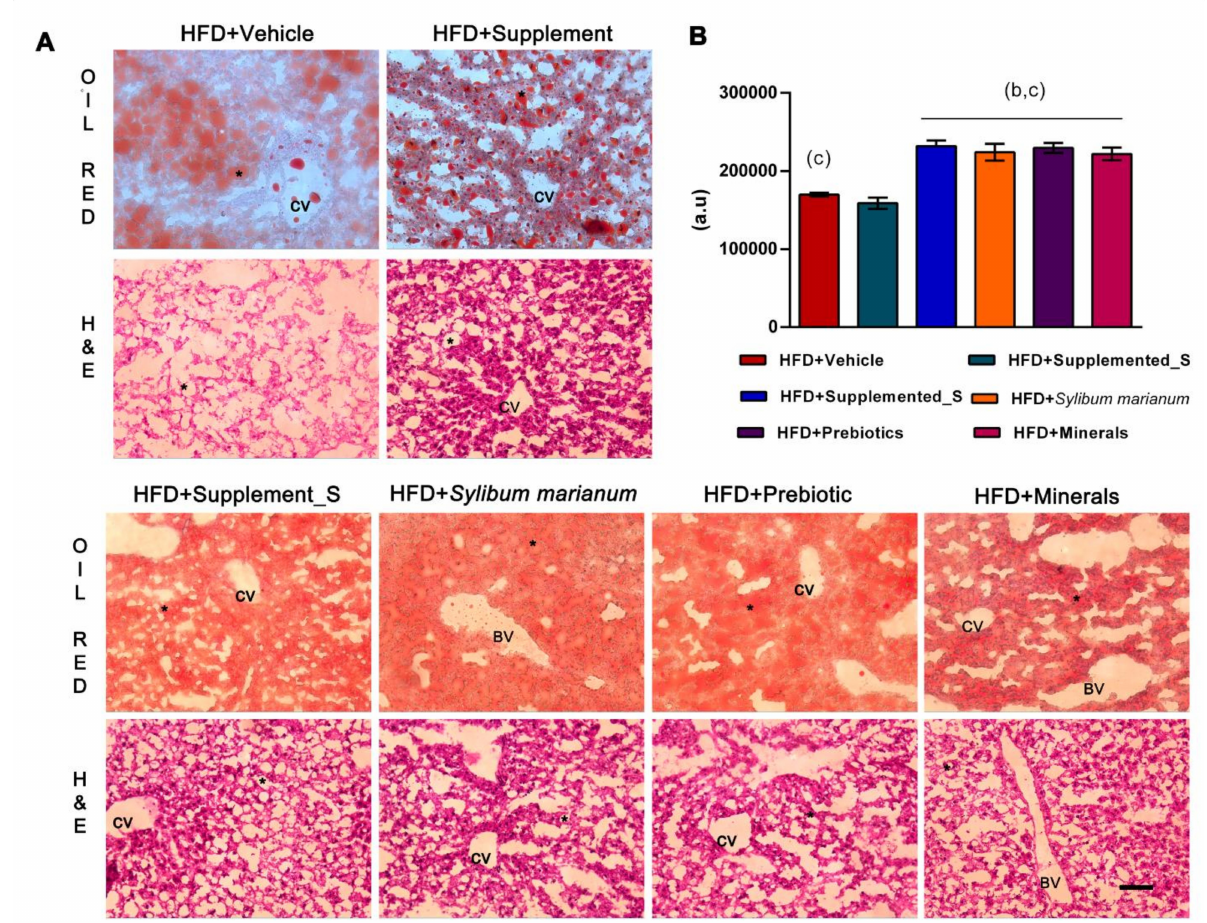
Figure 5. Visualization and quantification of ectopic fatty acids’ accumulation in liver samples. ( A ) Histological analysis of neutral lipids by oil red analysis and H&E staining in liver sections from mice on HFD. Each image contains a representative histological liver section image from each group. Scale bars, 50 µ m; magnification is × 20; BV: blood vessel; CV: central vein; (*): lipid droplets. ( B ) RGB measurement of oil red lipid staining in liver sections. p < 0.05 compared with HFD + Vehicle (b) and HFD + Supplemented (c) mice versus HFD + Supplemented_S, versus HFD + Silybum marianum , versus HFD + Prebiotics, and versus HFD + Minerals. HFD = high-fat diet. Values are means ± SD. Significant p < 0.05 in unpaired t -test: n = 3–5 per